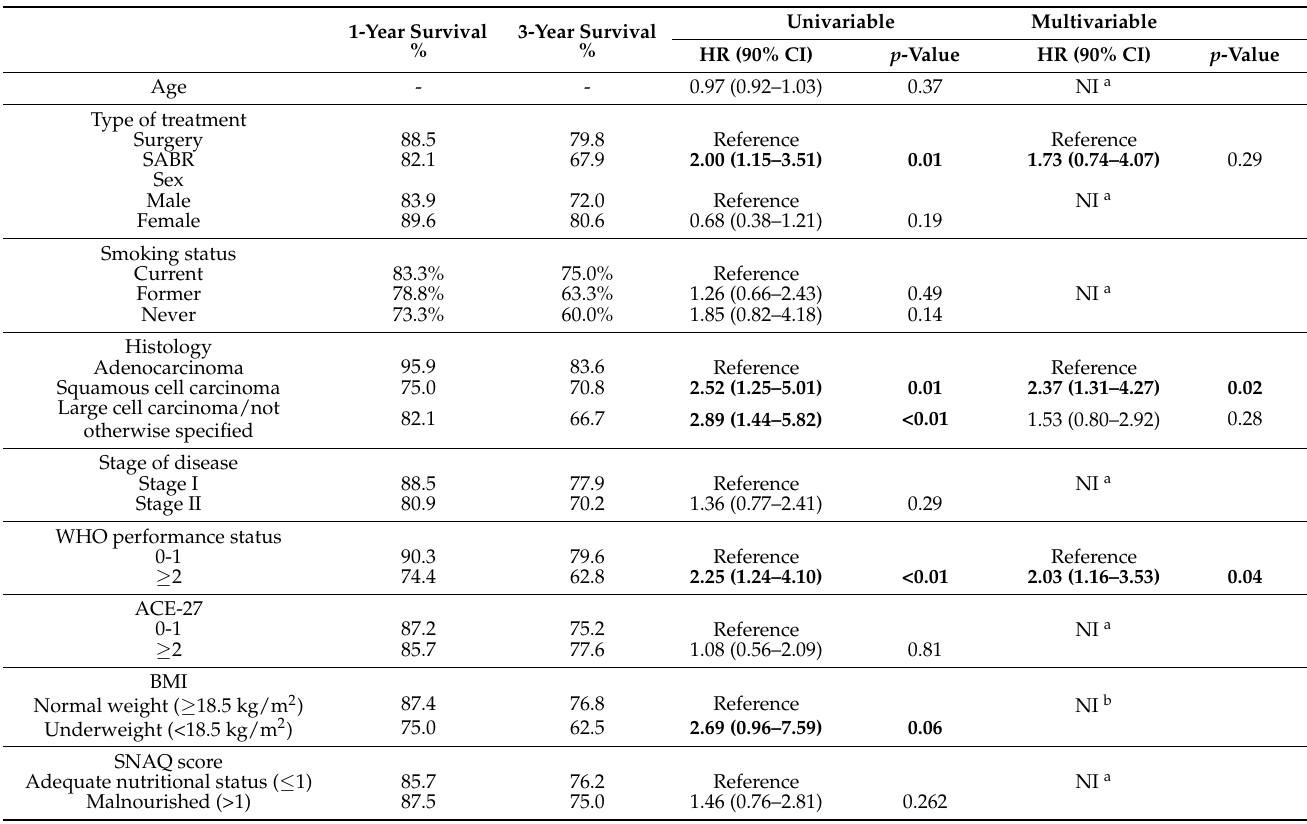
Table 5. Univariable and multivariable hazard ratios and 95% CIs for associations of pretreatment patient, tumor, and treatment characteristics with overall survival in patients with stage I–II NSCLC. 1-Year Survival 3-Year Survival %